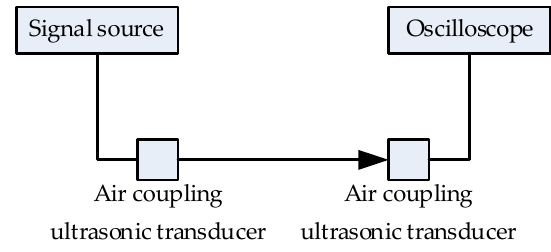
Figure 2. Schematic diagram of one-shot, one-take mode test.